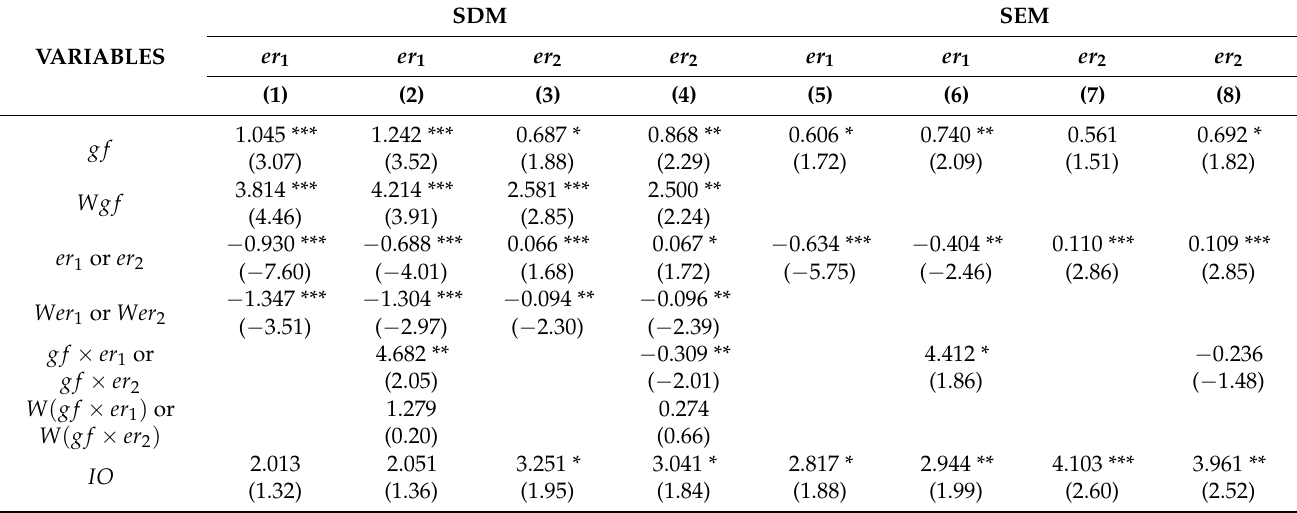
Table 5. Comparison of SDM and SEM under w 1 weight